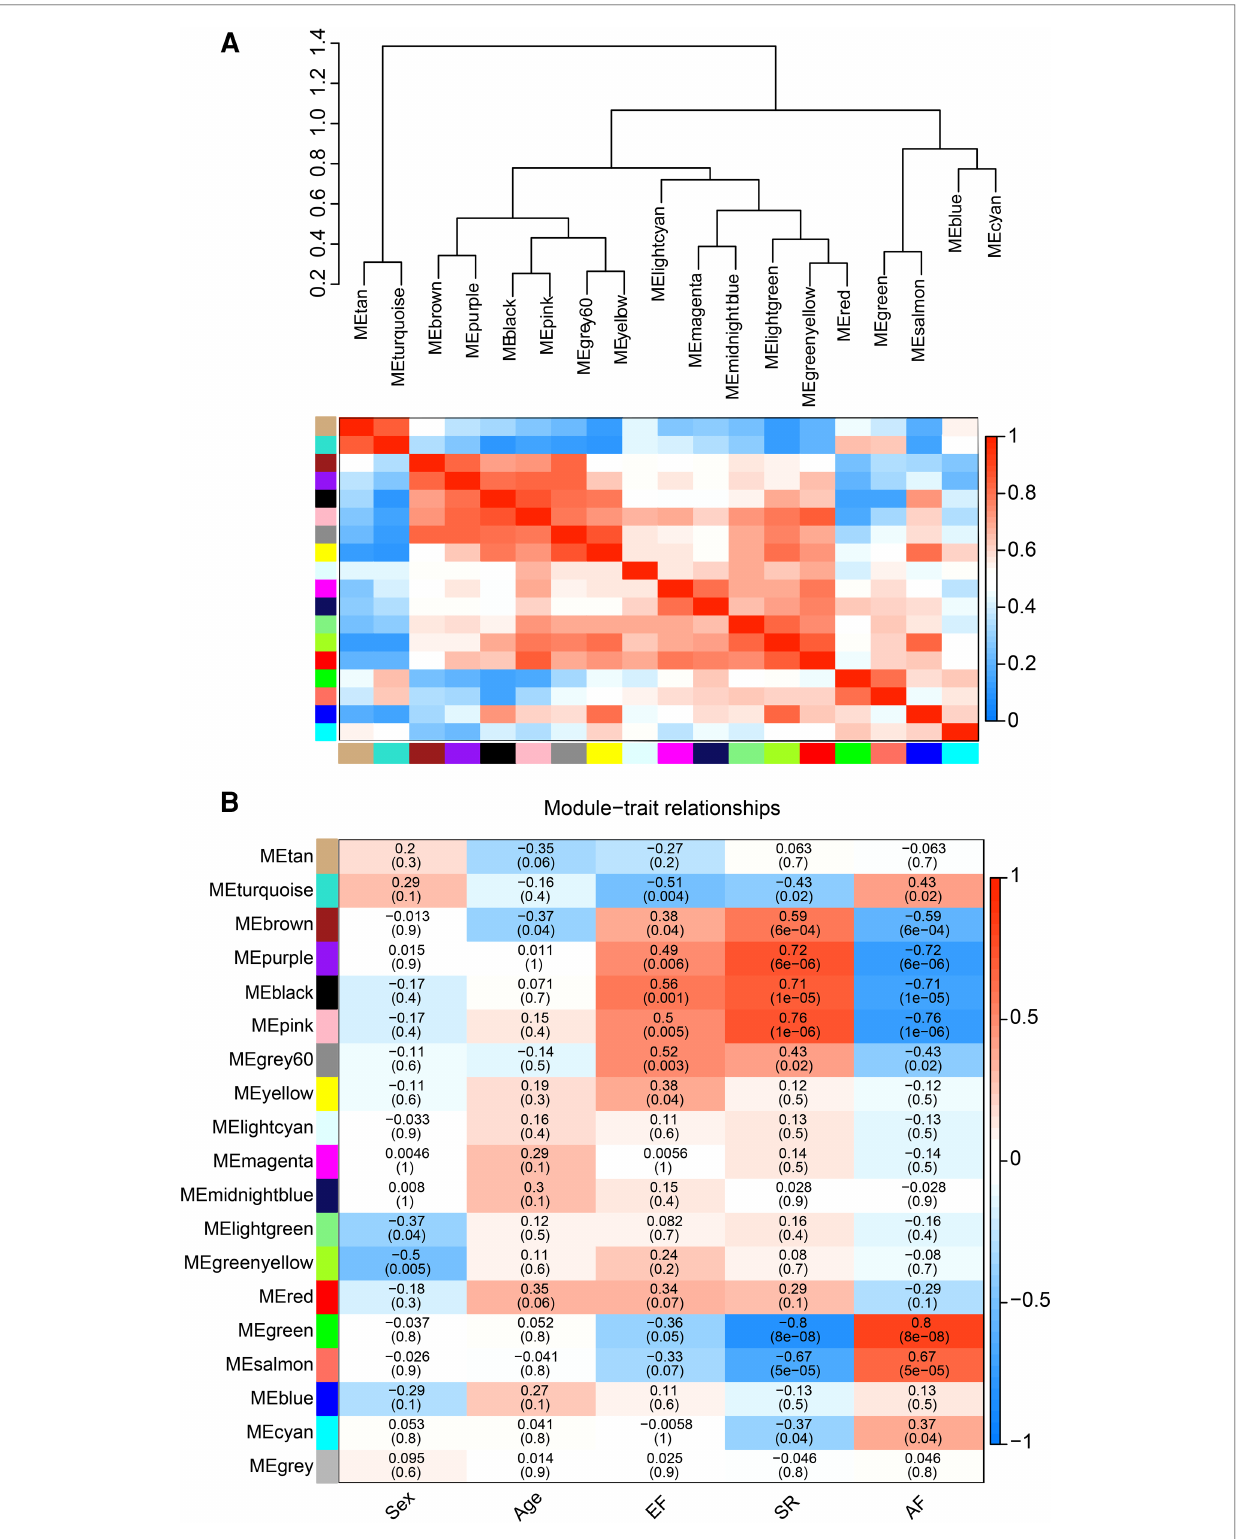
FIGURE 4 Correlation between co-expression modules and clinical traits. ( A ) Hierarchical clustering trees and heatmap of different modules. The red shows positive correlation and blue shows negative correlation. ( B ) Correlation relationship between each network module and traits. The values in the matrix cell indicate the correlation coef fi cient and the related p